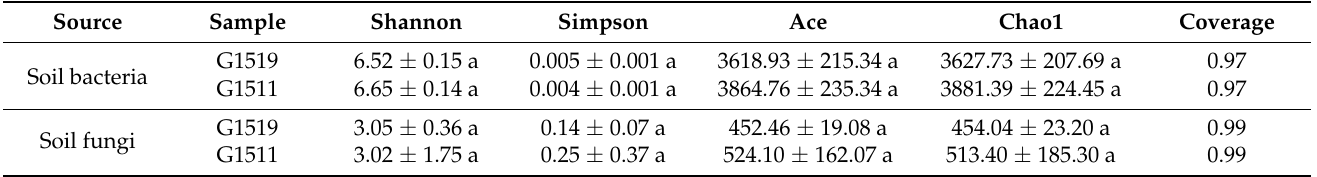
Table 3. Comparison of soil bacterial and fungal diversity indices in rhizospheres of G1519 and